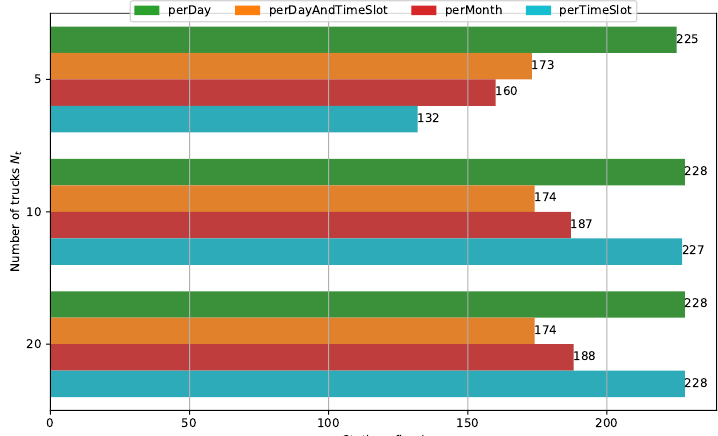
Figure 11. Number of fixed stations with varying N t .